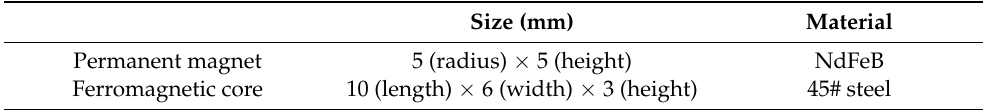
Table 4. Linear regression of the experimental results.